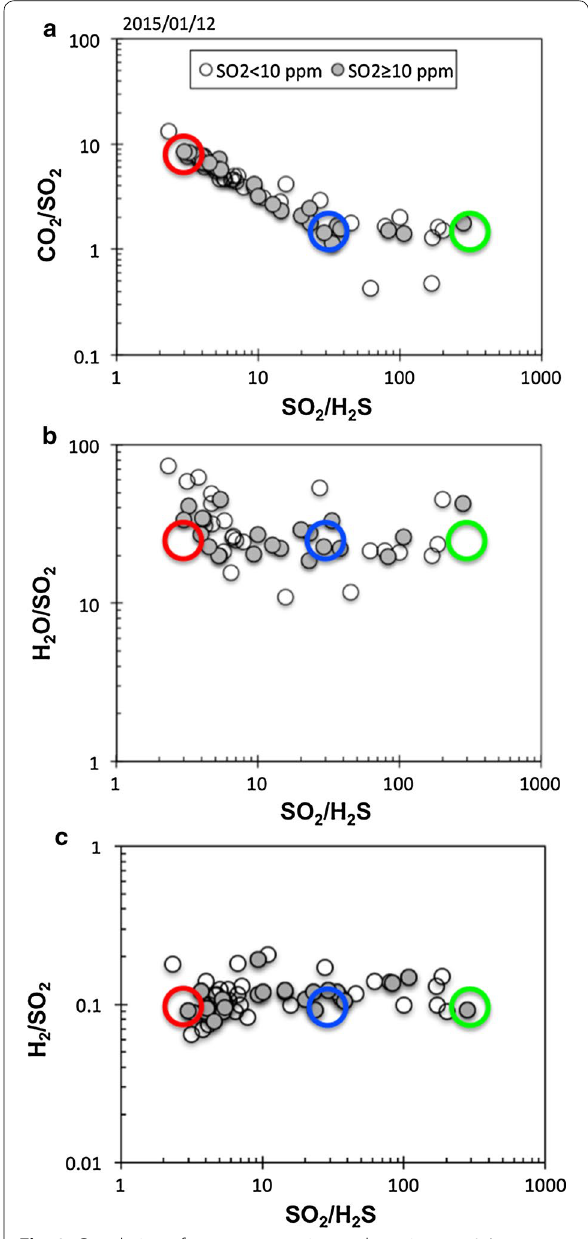
Fig. 8 Correlation of gas concentration molar ratios on 12 January 2015. a correlation of CO 2 /SO 2 molar ratio with SO 2 /H 2 S molar ratio, b correlation of H 2 O/SO 2 molar ratio with SO 2 /H2 S molar ratio, and c correlation of H 2 /SO 2 molar ratio with SO 2 /H 2 S molar ratio. Grey circles show ratios obtained for high concentration peaks of SO 2 ppm, and white circles are ratios of low concentration peaks of SO 2 < 10ppm. Red, blue and green circles indicate the compositions A, B and C,